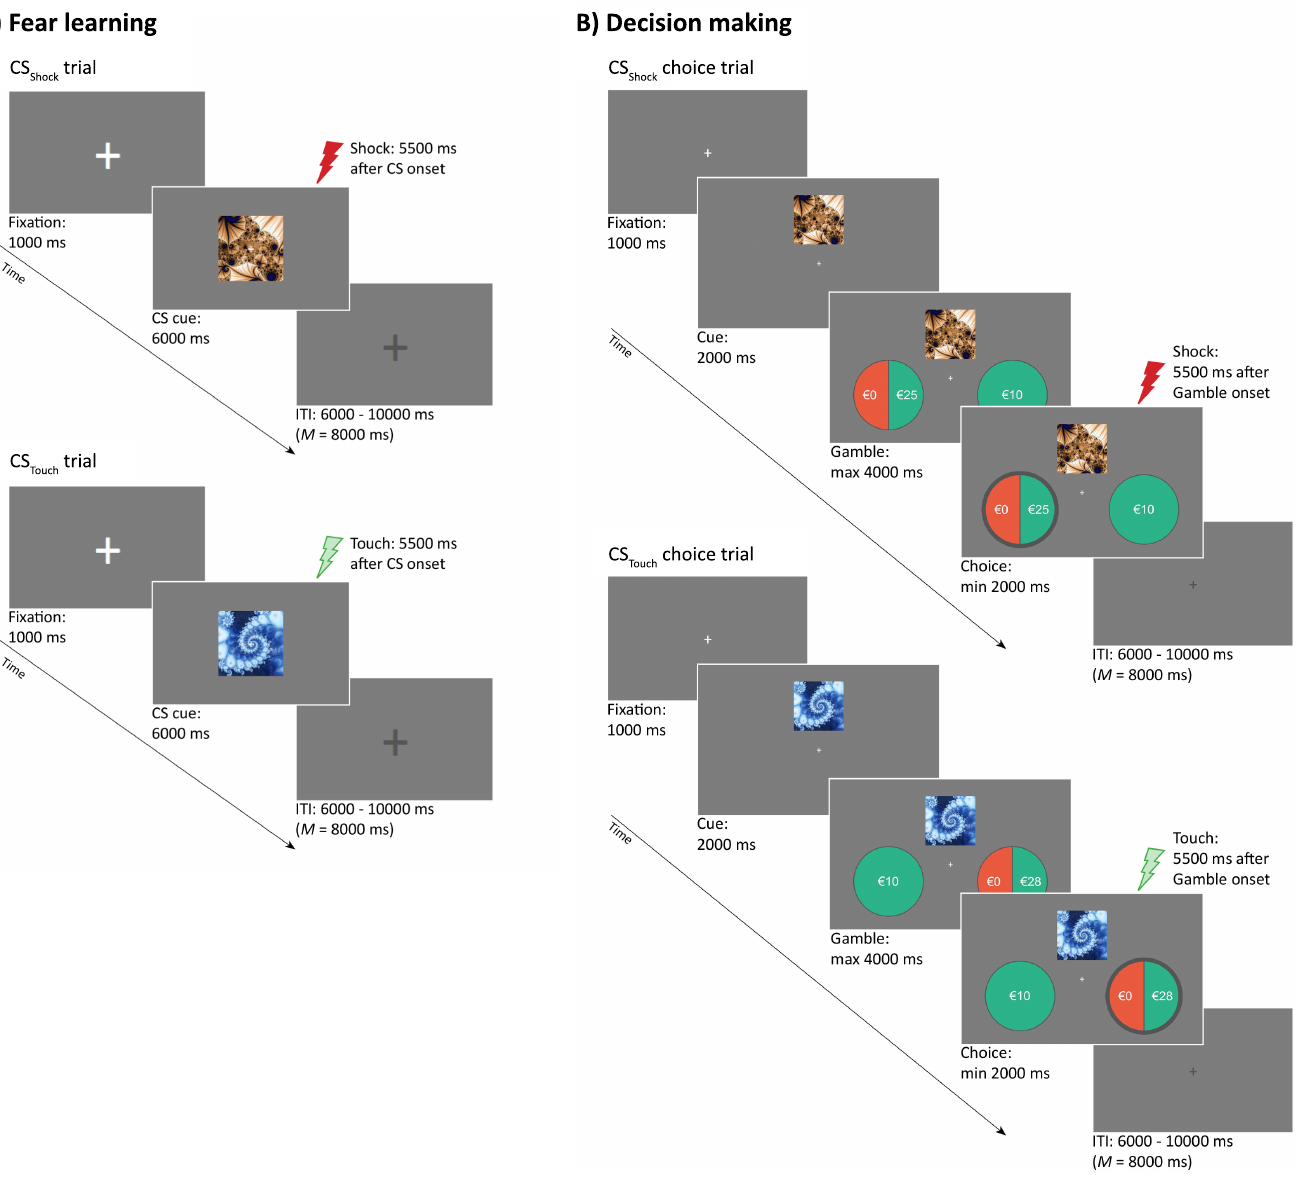
Fig 1. Experimental design. ( A ) Fear conditioning procedure. Participants were fear-conditioned to a visual conditioned stimulus (CS Shock ) through multiple parings with an aversive unconditioned stimulus (Shock). A control stimulus (CS Touch ) was paired with a neutral event (Touch). Reinforcement rate is 50%. ( B ) Decision- making task. Participants made a series of choices between a safe and risky option in the context of either a CS Shock or CS Touch . Reinforcement rate is 30%. Note . Red and green lightning depicts the presentation of the Shock and Touch, respectively.